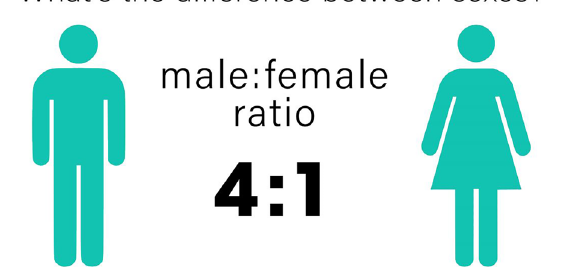
Figure 5. Sex differences for esophageal adenocarcinoma (EAC). Higher in males (ratio 4:1), UH Seidman Cancer Center Database (2005–2020).